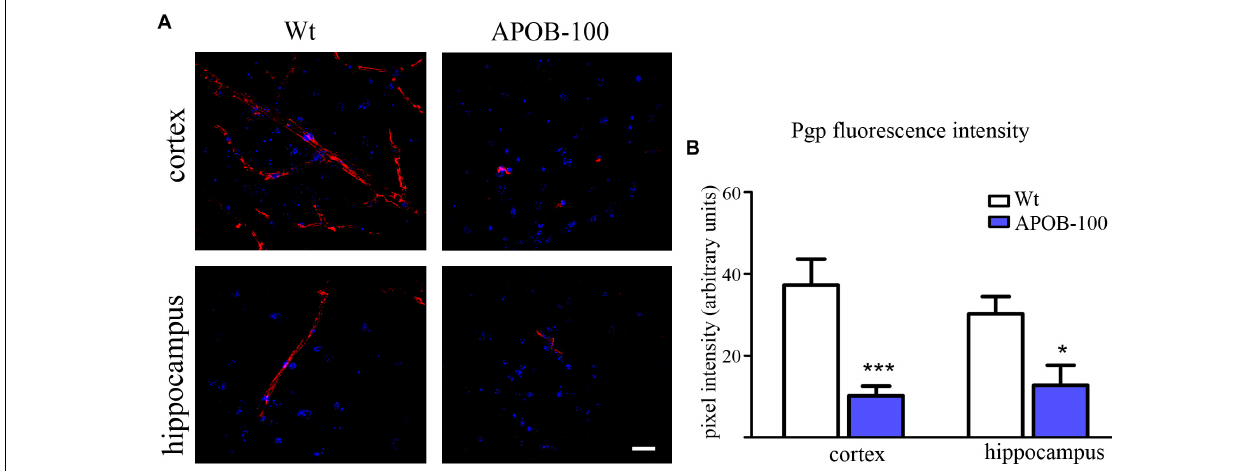
FIGURE 4 | P-gp (ABCB1) transporter immunostaining pattern (red) in cortical and hippocampal areas of wild-type (Wt) and APOB-100 transgenic mice (APOB-100), counterstained with DAPI (blue) (A) . Scale bar: 20 µ m. Quantification of fluorescence intensity of P-gp immunolabeling in the frontal cortex and hippocampus of Wt and APOB-100 transgenic mice (B) ∗∗∗ P < 0.001, ∗ P < 0.05, compared with Wt mice.